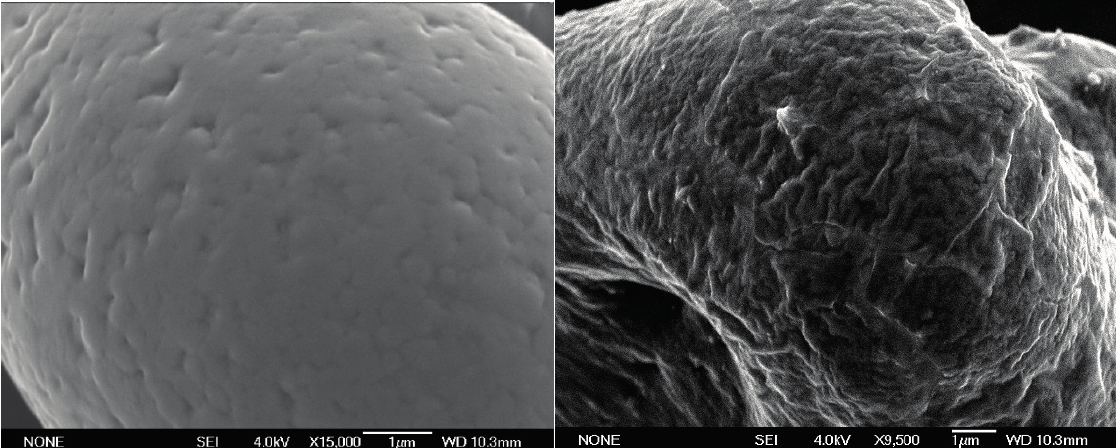
Figure 2. Electron microscopic images (SEM) of 2 ∞ [Sm 2 Cl 6 (bipy) 3 ]·2bipy ( 5 ) for an activation of the MOF at 300 °C at 10 − 6 mbar and an activation time of 24 h ( left ) and 96 h ( right ) indicating the ongoing surface